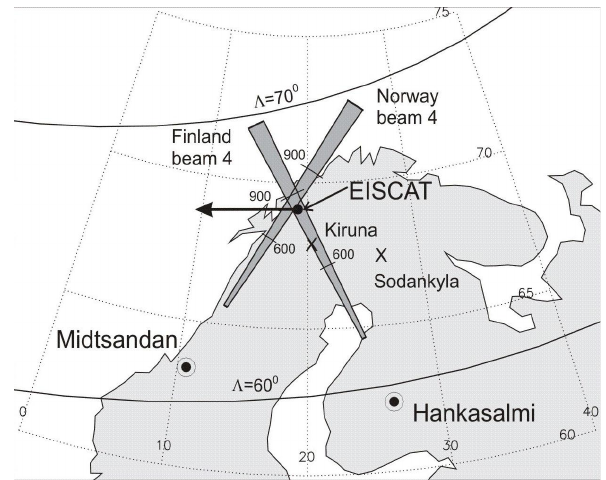
Fig. 1. Orientation of the Hankasalmi (Finland) STARE radar beam 4 and the Midtsandan (Norway) STARE radar beam 4 (as- suming 110-km height of backscatter). The short curved lines across the beams are slant range marks of 600 and 900km. The solid dot denotes an area where ionospheric parameters were mea- sured by the EISCAT incoherent scatter facility, consisting of the UHF transmitter/receiver at Tromso and receivers at Kiruna and Sodankyla (crosses). The solid thick lines indicate PACE (Polar Anglo-American conjugate experiment) magnetic